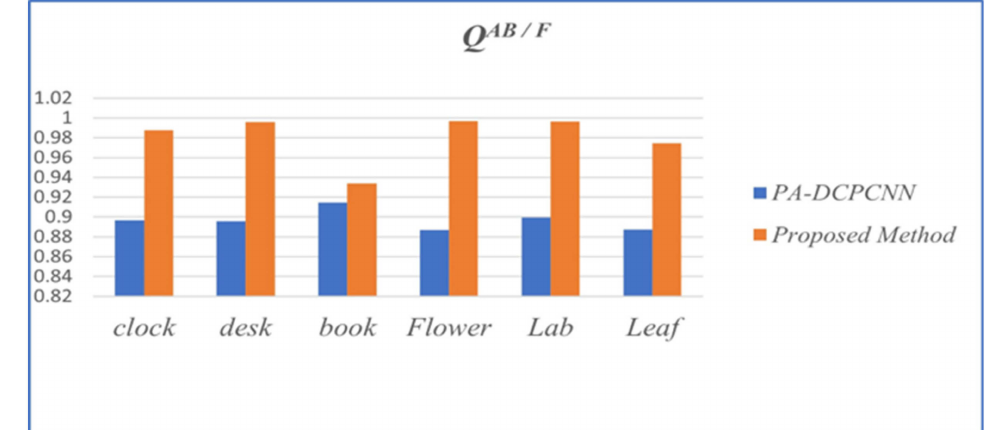
Figure 25. Performance evaluation of image-fusion techniques in reference to Q AB/F .